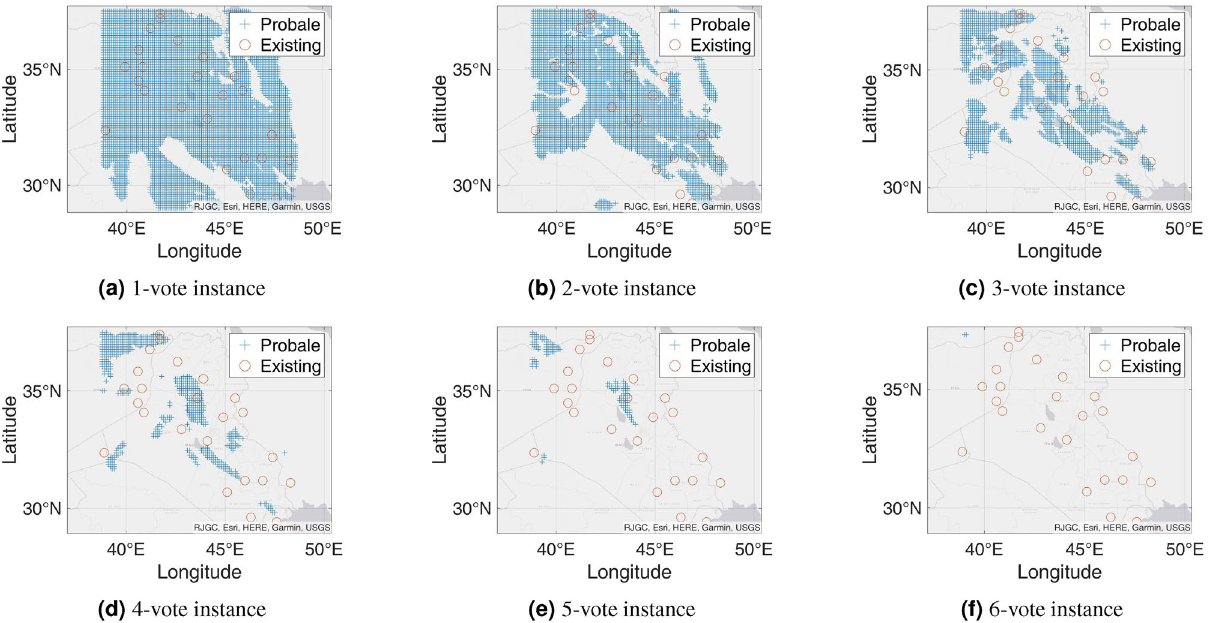
Figure 10. Probable petroleum deposits based on the existence of 1 to 6 votes over our 6 best-performing models found from the graph-based analysis (the figures are created using MATLAB 2021a 51 ).